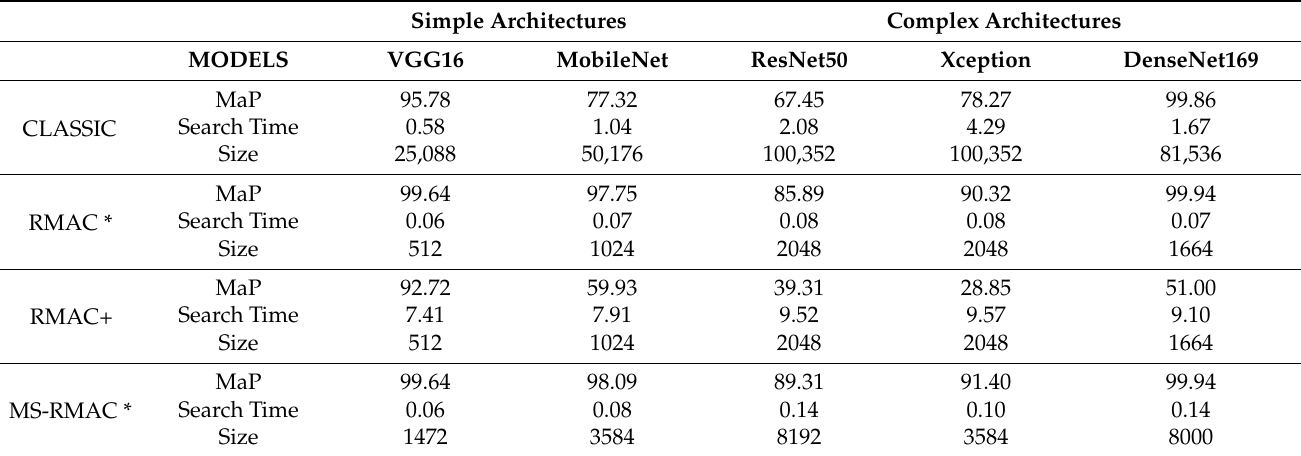
Table 6. Synthesis of RMAC methods results.